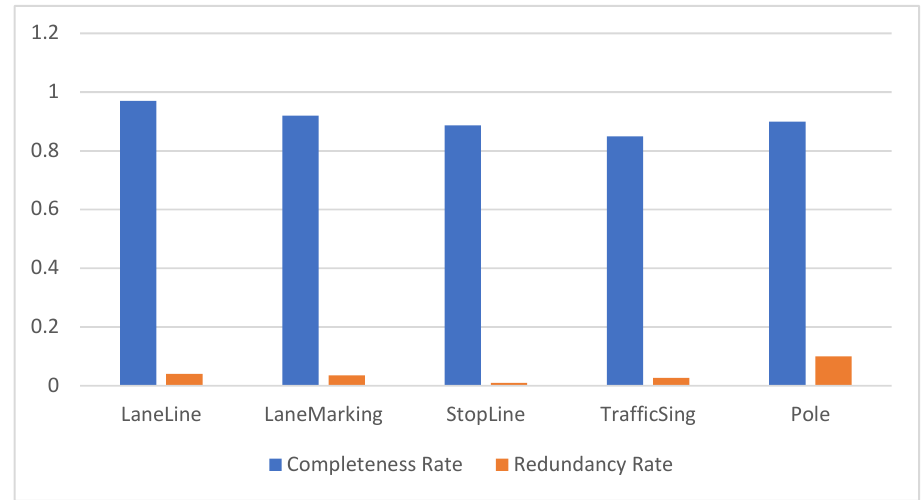
Figure 8. Statistical results of completeness and redundancy of crowdsourced fusion mapping on-cloud on different semantic elements.